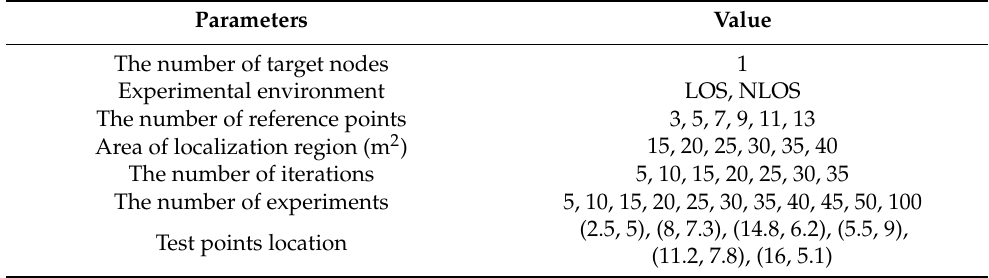
Table 1. Experimental